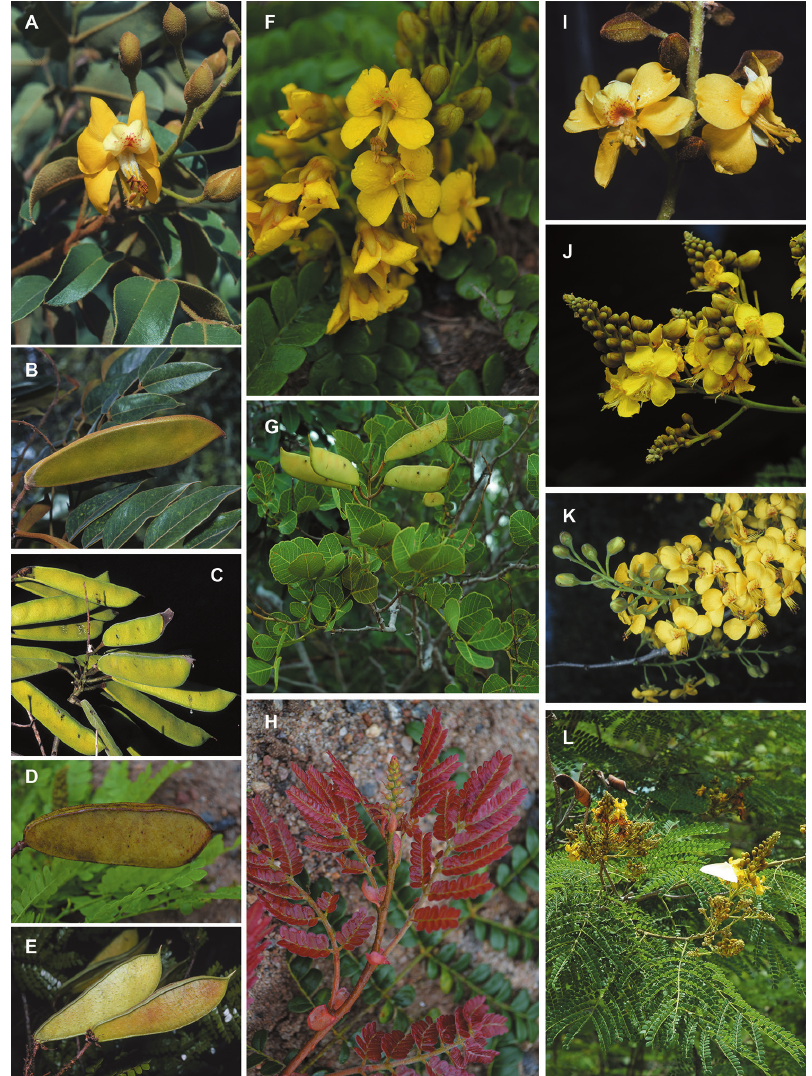
Figure 30. Cenostigma macrophyllum Tul. A flower (G. P. Lewis, Piauí, Brazil, Lewis 1342 (K)) B fruit (G. P. Lewis, Brazil, unvouchered ). Cenostigma eriostachys (Benth.) E. Gagnon & G. P. Lewis C fruits (C. E. Hughes, Oaxaca, Mexico, Hughes 1935 (FHO)) I flowers (G. P. Lewis, Mexico, MacQueen et al. 408 (K) ) . Cenostigma pluviosum (DC.) E. Gagnon & G. P. Lewis cf. var. intermedium (G.P. Lewis) E. Gagnon & G. P. Lewis D fruit F inflorescence H a new flush of leaves (E. Gagnon, Bahia, Brazil, H.C. Lima et al. 7901 (RB)). Cenostigma pluviosum var. cabralianum (G. P. Lewis) E. Gagnon & G. P. Lewis E fruits (G. P. Lewis, Brazil, Lewis et al. 2019 (K)). Cenostigma marginatum (Tul.) E. Gagnon & G. P. Lewis G leaves and fruits (C. E. Hughes, Bolivia, Wood et al. 26514 (K)). Cenostigma pluviosum (DC.) E. Gagnon & G. P. Lewis var. pluviosum J inflorescences L inflorescences, foliage and dehisced fruits (C. E. Hughes, Santa Cruz, Bolivia, Wood et al. 26552 (K)). Cenostigma gaumeri (Greenm.) E. Gagnon & G. P. Lewis K inflorescence (C. E. Hughes, Quintana Roo, Mexico, Lewis & Hughes 1762